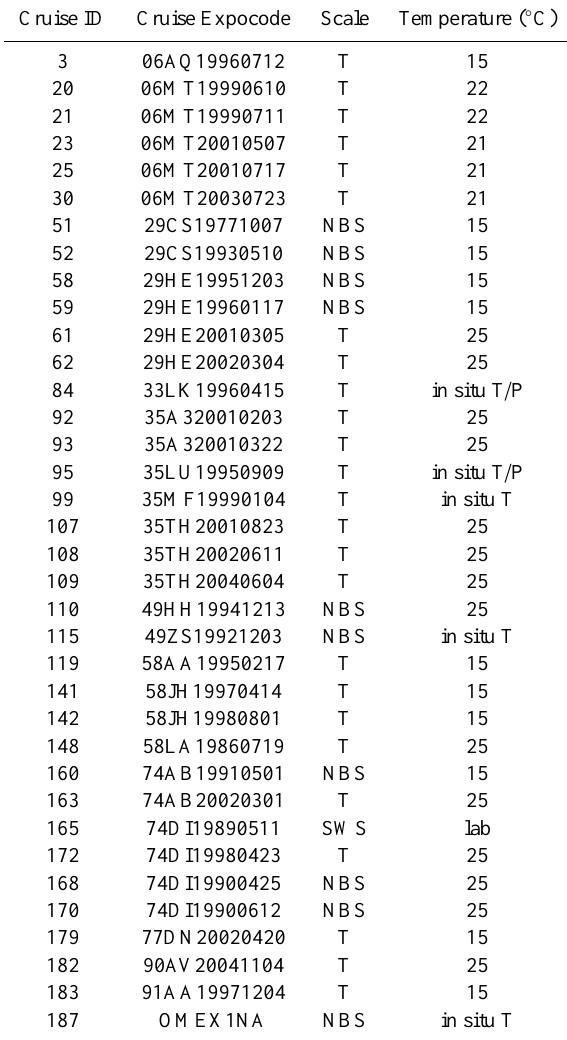
Table 3. Scale conversions. Note for cruise 165: Temperature spec- ified for each sample, between 16.42 and 22.04 ◦ C; Note for cruise 187: data quality low.